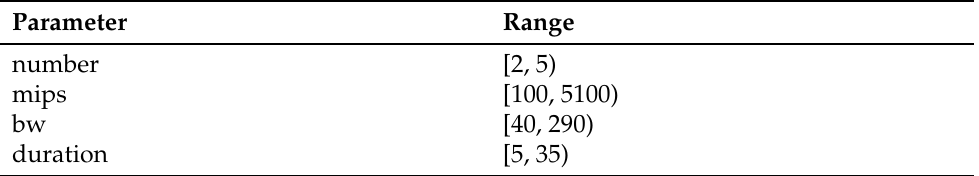
Table 2. Task generator